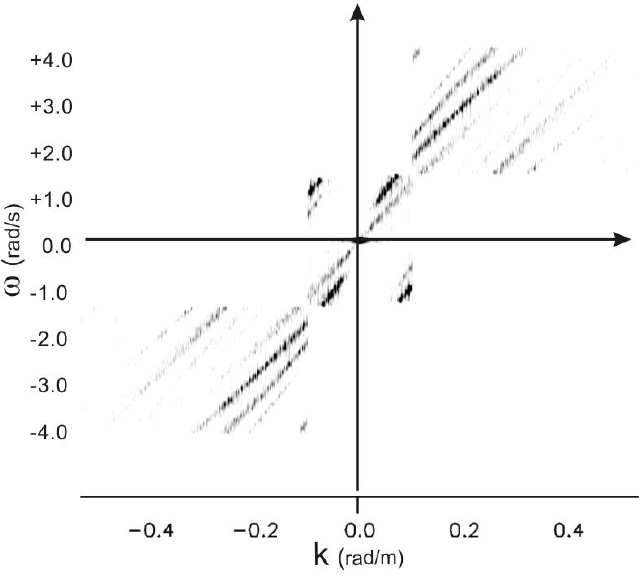
Figure 16. The assembled spectrum according to the procedure in